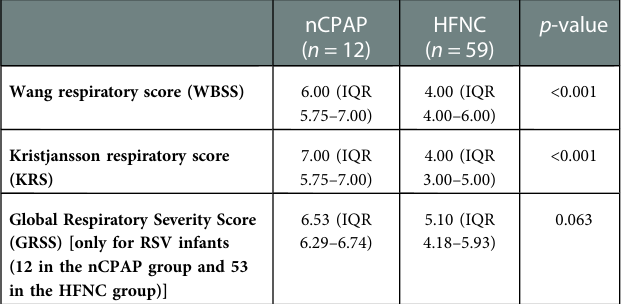
TABLE 6 Comparison of three bronchiolitis scores (WBSS, KRS, GRSS) between infants who required nasal continuous positive airway pressure (nCPAP) and infants managed only with high- fl ow nasal cannula